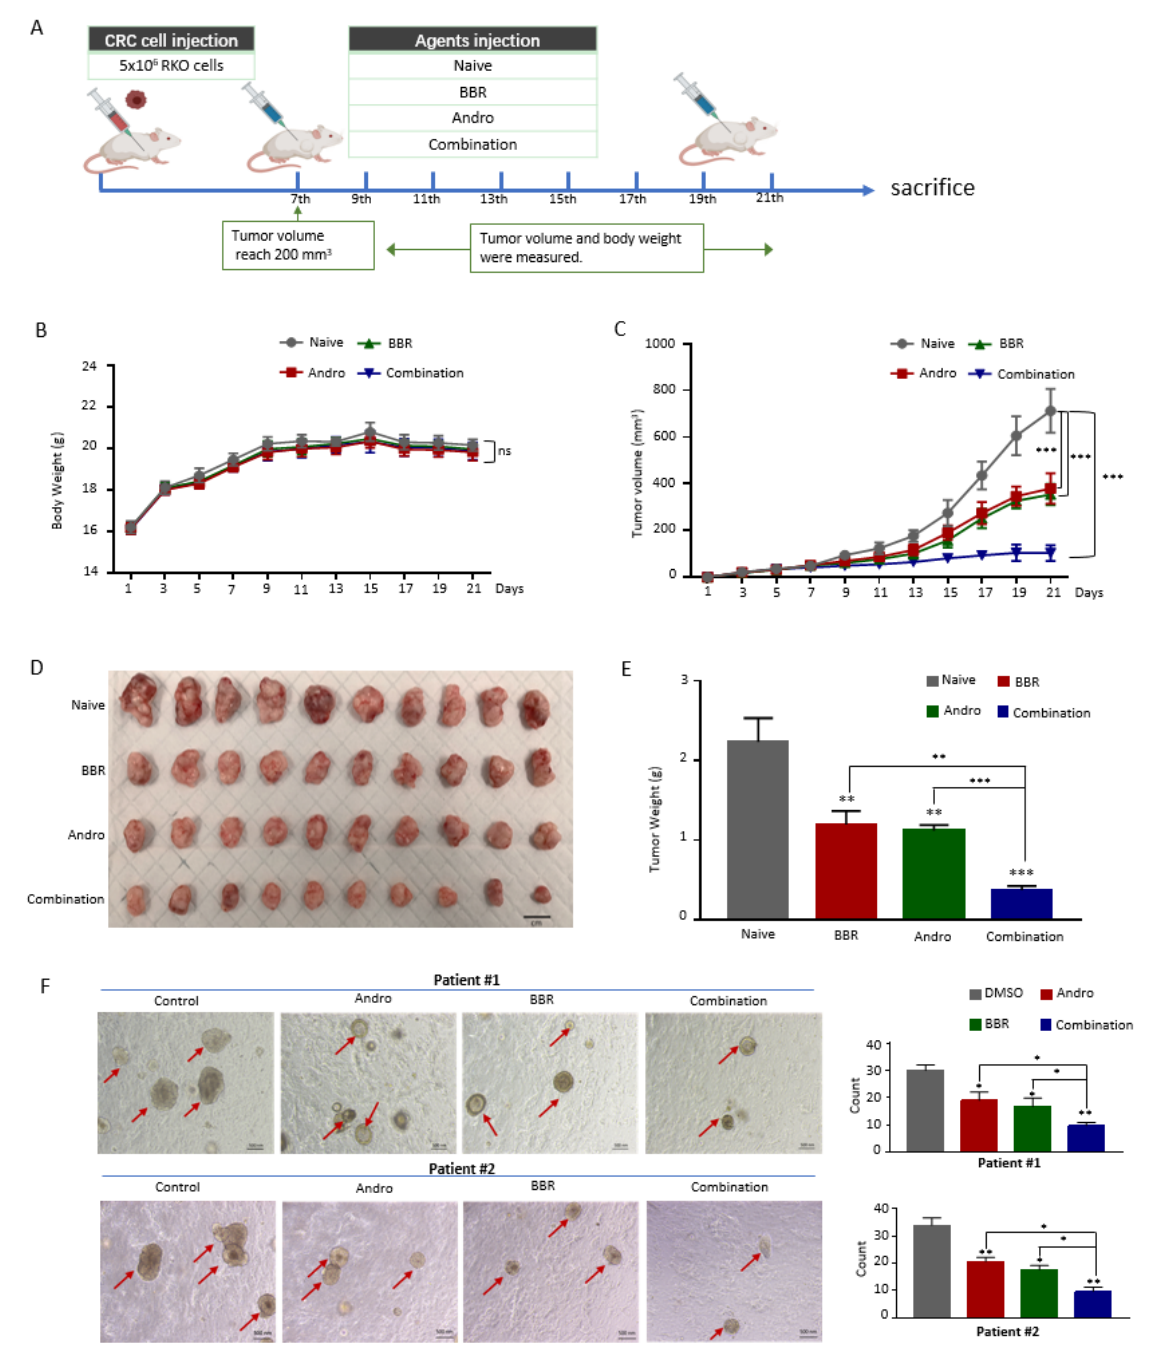
Figure 3. Andrographis enhances the efficacy of berberine in mouse xenografts and patient-derived tumor organoids. ( A ) A schematic diagram of the RKO xenograft model in nude mice and the treat- ment schedule of berberine, Andrographis, and their combination; ( B ) The bodyweight alterations of the mice in each treatment group were measured at different time-points after inoculation; ( C ) The tumor volume alterations of mice in each treatment group were measured at different time-points after inoculation; ( D ) Representative images of anatomic tumor xenografts dissected from nude mice after they were sacrificed; ( E ) The measurement of the xenograft weights of each treat- ment group; ( F ) Microscopic images of patient-derived tumor organoids derived from two patients cultured in each treatment group (20× magnification). The organoid count analysis is shown in the right panel. Statistical Significance: * p < 0.05, ** p < 0.01, *** p < 0.001. BBR, berberine; Andro, An- drographis.